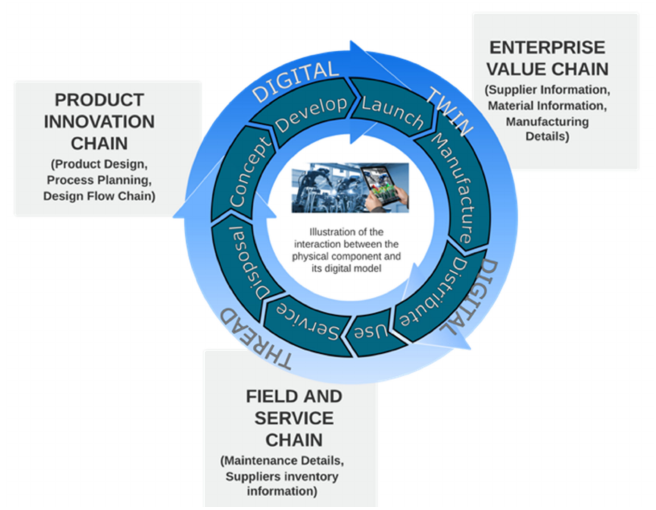
Figure 5. The concept of digital thread to complement digital